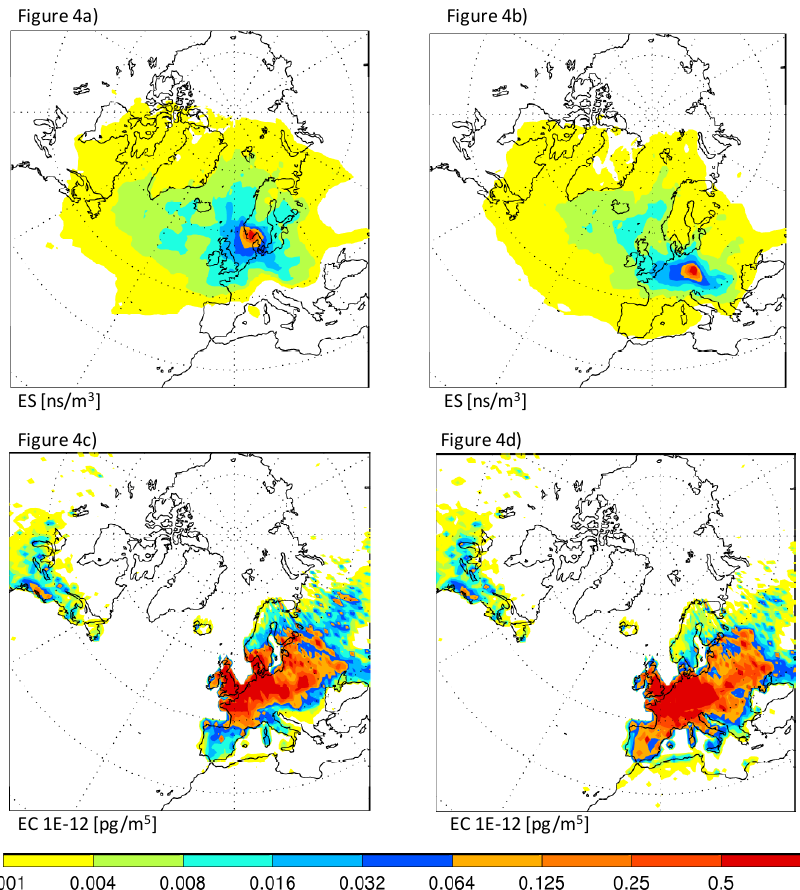
Fig. 4. (a-d): Maps of Footprint ES (emission sensitivity) (a) , (b) and EC (emission contribution) (c) , (d) for PCB-28 for the PAS sampling period at Birkenes (a) , (c) and Koˇsetice (b) , (d) (see text for